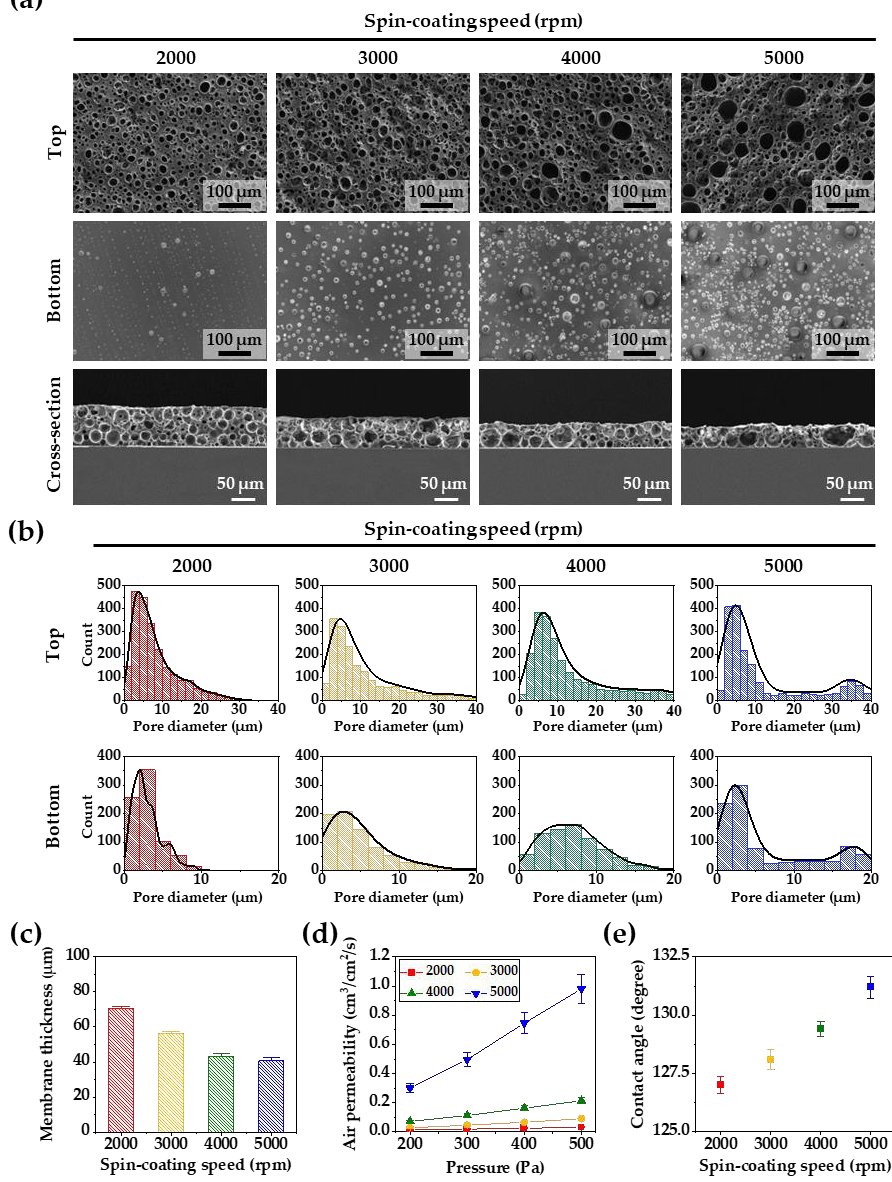
Figure 2. ( a ) SEM images of the top, bottom, and cross-section views of the porous PDMS membranes according to different spin-coating speeds. ( b ) The pore size distributions of the top and bottom sides of the porous PDMS membranes. ( c ) The membrane thickness at spin-coating speeds of 2000, 3000, 4000, and 5000 rpm. ( d ) Air permeability of the porous PDMS membranes as a function of pressures. ( e ) Water contact angles of the porous PDMS membranes surfaces according to different spin-coating speeds. For all the samples, the PDMS solution was mixed for 5 min using a modified Rushton impeller.